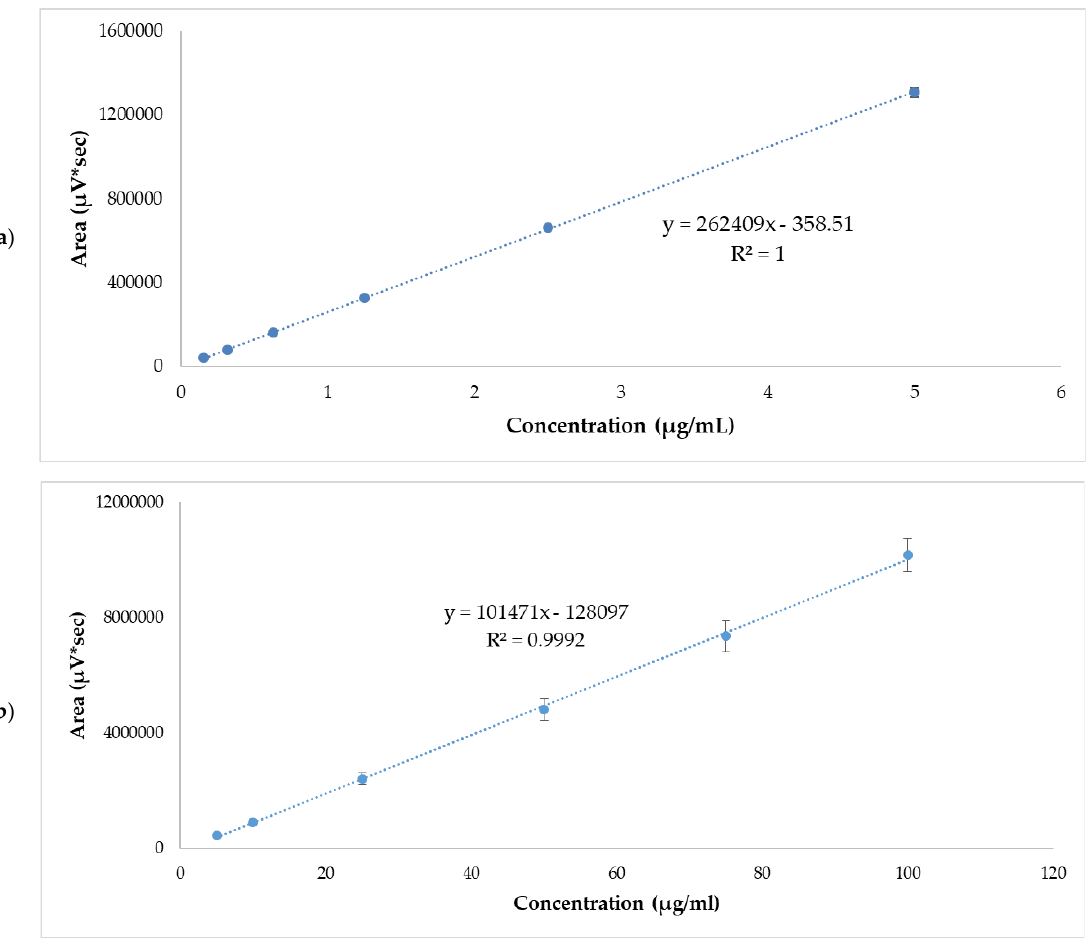
Figure 1. APR standard calibration curves. ( a ) Low range mean values, 0.156 - 5 µg/mL. ( b ) High range mean values, 5 - 100 µg/mL. Results are expressed as mean ± SD ( n = 5). Table 5. Accuracy and precision inter-day data for APR standard solutions. Low range. Theoretical Conc. ( µ g/mL)